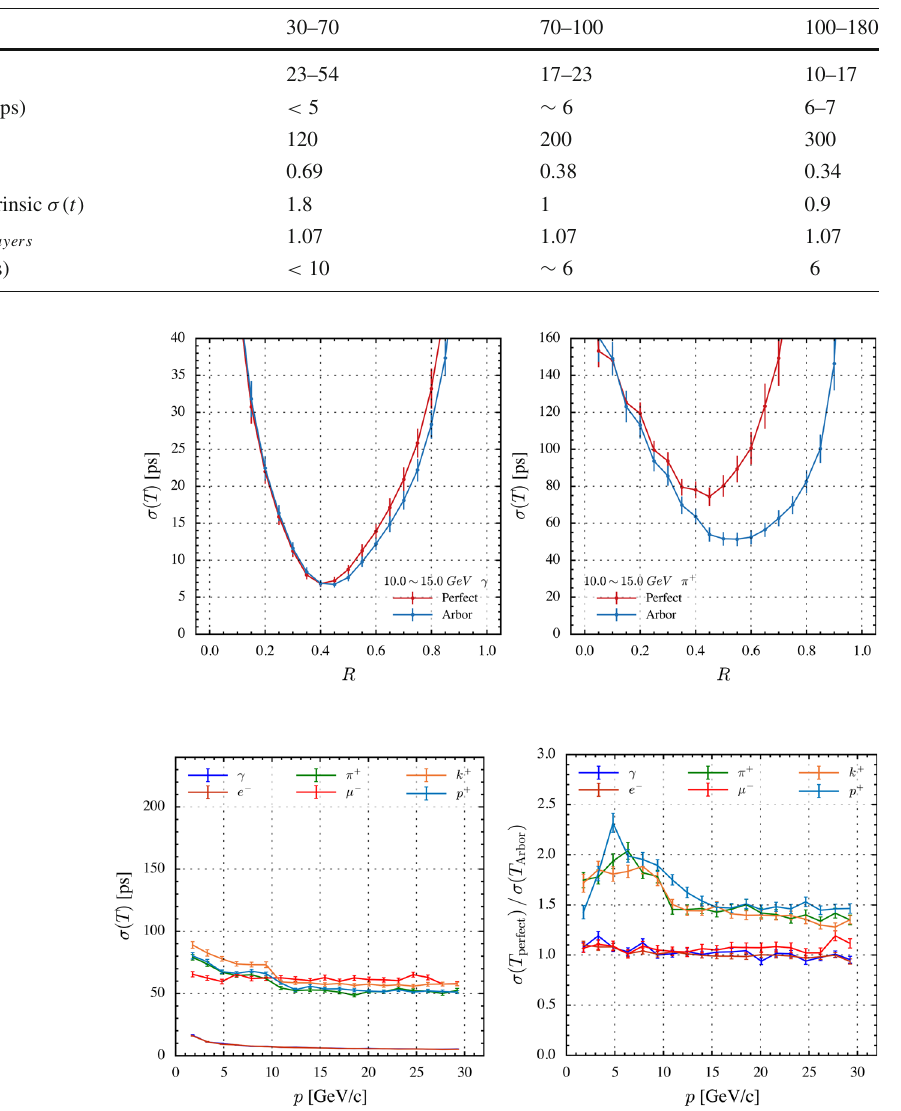
Table 3 The depletion thickness of silicon sensors, assumed noise term coefficient of the intrinsic time resolution (which is the same with the beam test result in Ref. [1]), and ToF resolution for photons with transverse momentum of 5 GeV estimated in the setup of CEPC ECAL and the three